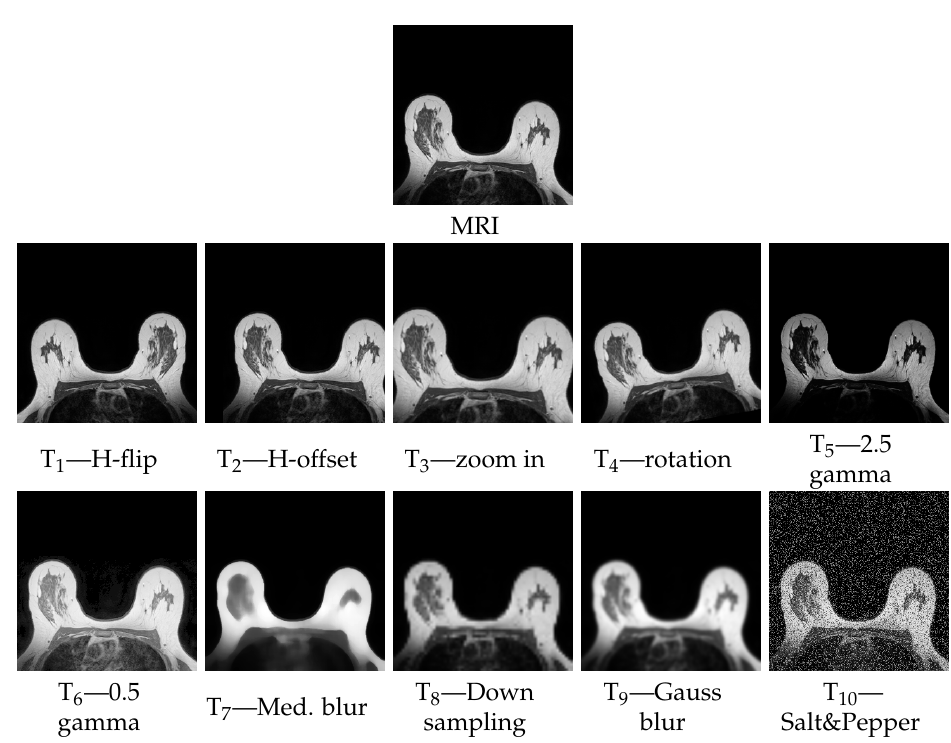
Figure 4 show the reference and tampered MRI images. Respective FID and SSIM values are presented in Table 1.